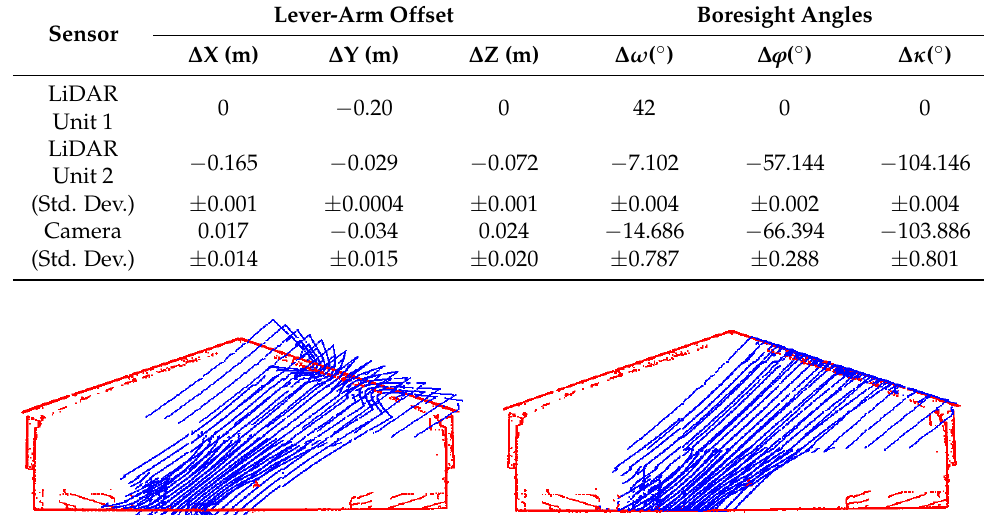
Table 3. EstimatedmountingparametersrelatingtheLiDARandcameraunitstothepolecoordinateframe. Figure 21. Sample images captured by the SMART system inside the site used for evaluating the inter-sensor mounting parameters.